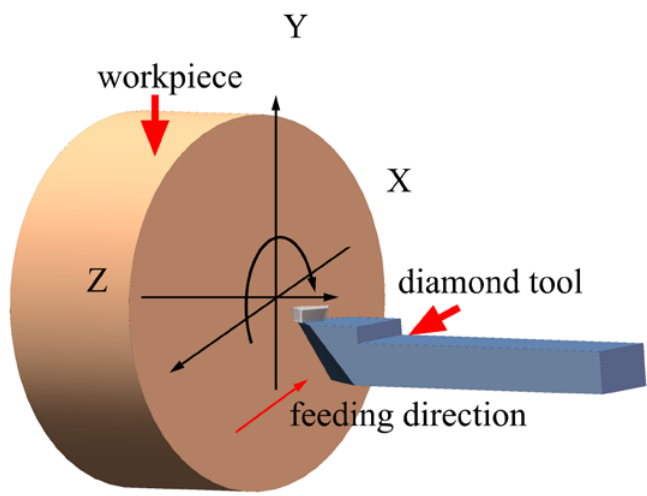
Figure 2. Schematic diagram of the ultra-precision diamond turning process, where the diamond tool moves from the edge towards the center of the workpiece.